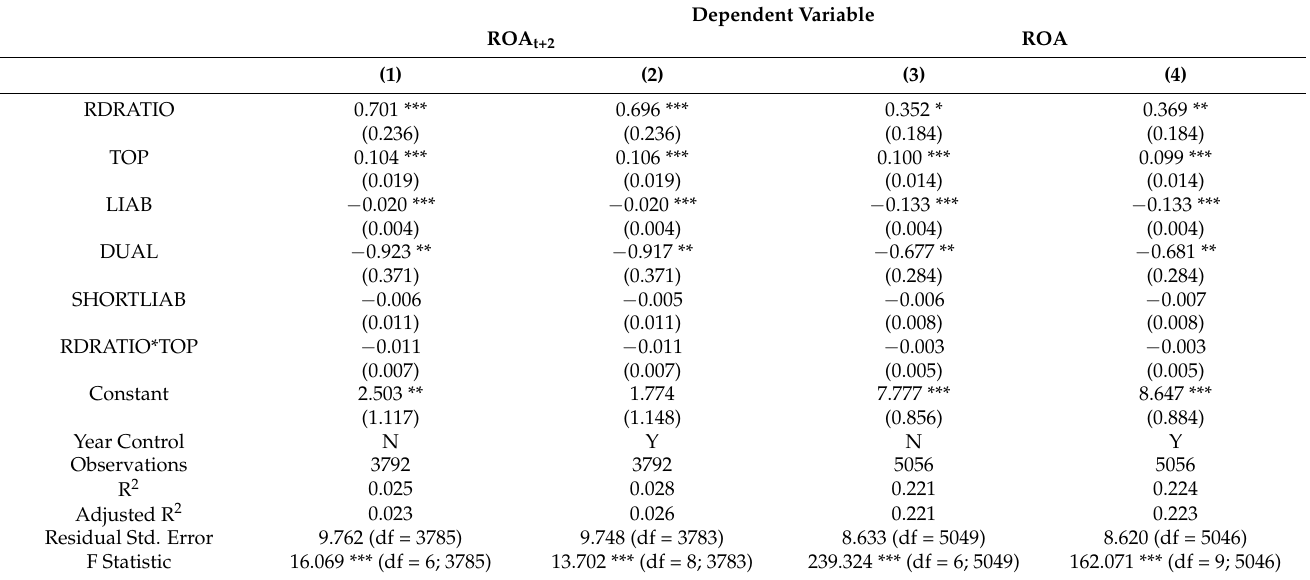
Table 4. Robustness check: